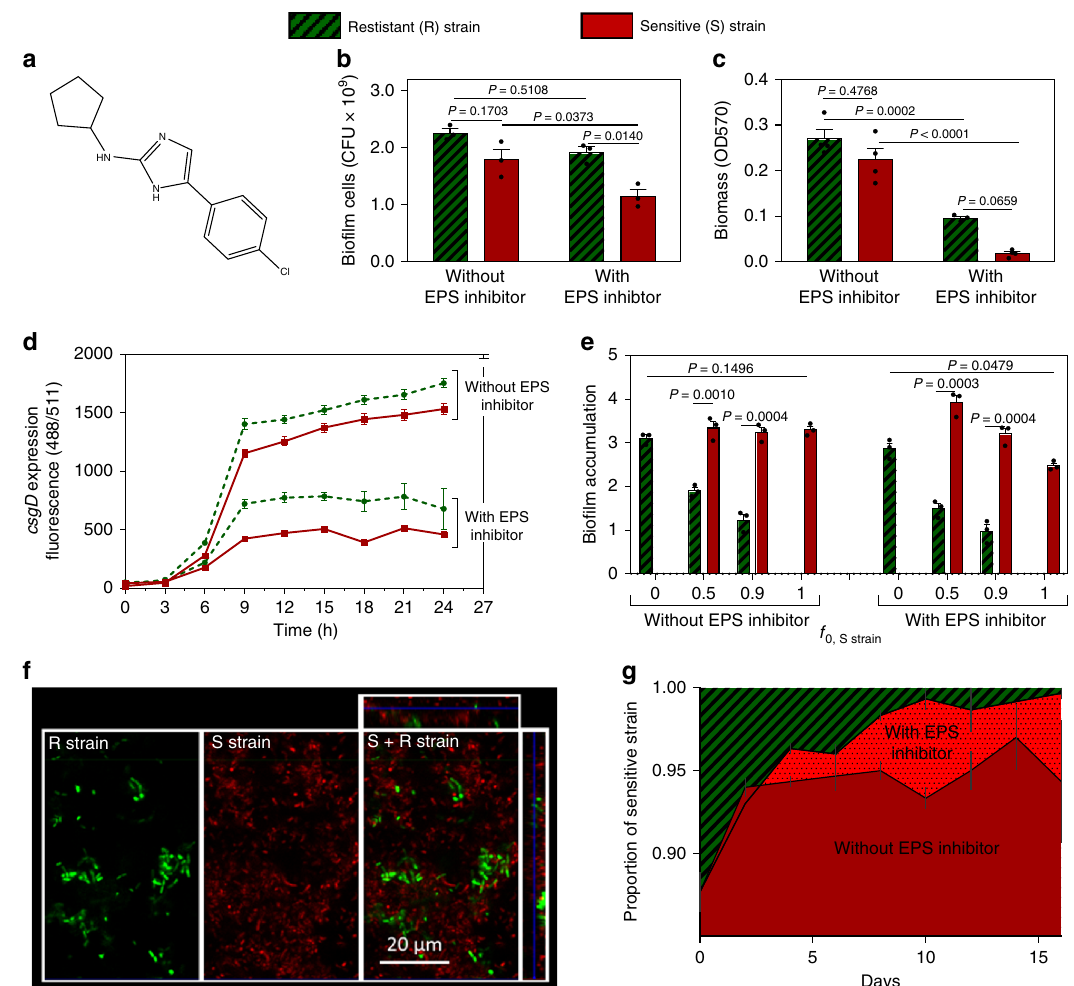
Fig. 4 A resistant Salmonella strain (R) is outcompeted by a sensitive strain (S) under inhibitor (50 µ M ) treatment. Strain resistant to EPS inhibitor (SGSC3068) is indicated in (shaded) green; Strain sensitive to EPS inhibitor (SGSC2227) is indicated in red. a Chemical structure of EPS inhibitor 2- cyclopentenyl-5-(4-chlorophenyl)-2-aminoimidazole. b Number of cells in monoculture bio fi lms. c Amount of biomass in monoculture bio fi lms. d csgD expression of monoculture bio fi lms of R strain (dashed green line) and S strain (full red line) in function of time. e Normalised bio fi lm accumulation of each strain during short-term competition ( f 0, S strain = initial inoculation fraction of the S strain). f Confocal image of association between EPS producer and non- producer in the bio fi lm ( f 0, S strain = 0.9); left: split images, right combined image. g Proportion of strains during 16 days of competition. Dark and bright red indicate proportion of sensitive strain in bio fi lms grown in the absence and presence of EPS inhibitor, respectively. For competition experiments e and g and microscopy f , resistant and sensitive strain were fl uorescently labelled in green and red, respectively. A similar outcome e and f was obtained when colors were reversed and competition was neutral when strains that only differ in the fl uorescent protein marker were competed against each other (Supplementary Figs. 14, 15a, c . Bars and lines represent mean, dots represent measurements for biological replicates and error bars show s.e.m. ( n = 3 biologically independent samples, except in Fig. 4c, where n = 4). P values derived from two-tailed student ’ s t test e using Welch ’ s correction if s.d. are signi fi cantly ( P < 0.05) different and two-way ANOVA b , c , with Bonferroni multiple comparisons correction. Source data are provided as a Source Data fi Competition experiments in bio fi lms . Competition was studied between wild- scraped off at t = 48h divided by the number of cells inoculated at t = 0 h: (cid:1) (cid:3) type S . Typhimurium ATCC14028 (labelled in green) and the isogenic Δ csgD ð 1 Þ mutant (labelled in red) and between the natural isolates SGSC2227 (labelled in red) and SGSC3068 (labelled in green). For short-term competition (48 h), the strains were separately grown in ON cultures, after which the OD 595 was measured The relative fi tness of the deletion mutants was calculated as the ratio between and corrected to an OD 595 of 3.2. The corrected cultures were diluted and co- the normalised bio fi lm accumulation of the mutant and the normalized bio fi lm inoculated in the appropriate ratios in 10ml 1/20 TSB, supplemented with EPS accumulation of the reference strain. inhibitor where needed, to obtain a total cell density ± 12× 10 7 ml − 1 and the exact For long-term competition, an inoculation ratio of 10% EPS producer (wild number of inoculated cells was determined by plate counting. Bio fi lms were grown type strain ATCC14028 or SGSC3068) and 90% EPS non-producer ( Δ csgD mutant in petridishes and scraped off after 48h as described above. To determine the or SGSC2227) was used. After 48 h of incubation in petridishes as described above, proportion of each strain at the different stages of bio fi lm formation (at 6h, 12h), the liquid medium above the bio fi lms was removed, after which the bio fi lms were parallel bio fi lm plates were set up and planktonic cells were harvested at 6h, and scraped off and divided into three parts. The fi rst part of 500 µL was used to re- bio fi lm cells scraped off at 12 h. CFUs were counted using an Illumatool Tunable inoculate in 10 ml 1/20 TSB to start a new cycle of bio fi lm competition in Lighting System (Lightools Research, Encinitas, CA) that allowed to distinguish petridishes, the second part (20 µL) was used to make serial dilutions to determine between green and red fl uorescent colonies. The normalised bio fi lm accumulation the number of bio fi lm cells by plate counting, and the third part (480µl) was stored of each strain was calculated as the binary logarithm of the number of bio fi lm cells at − 80°C. This cycle was repeated 17 times (34 days) and 8 times (16 days),